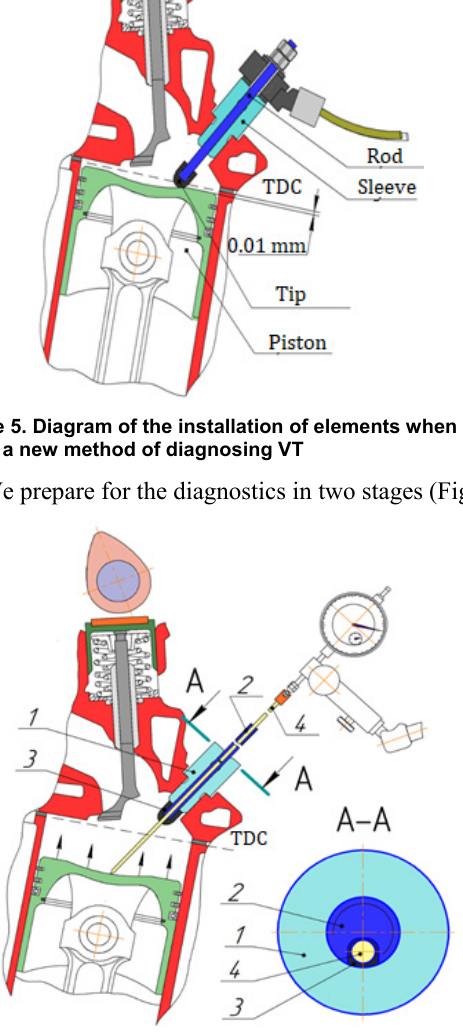
Figure 6. Preparation for measuring VT phases 1. Using a probe (pos. 4), we check the piston stroke of the cylinder for compliance with the standard